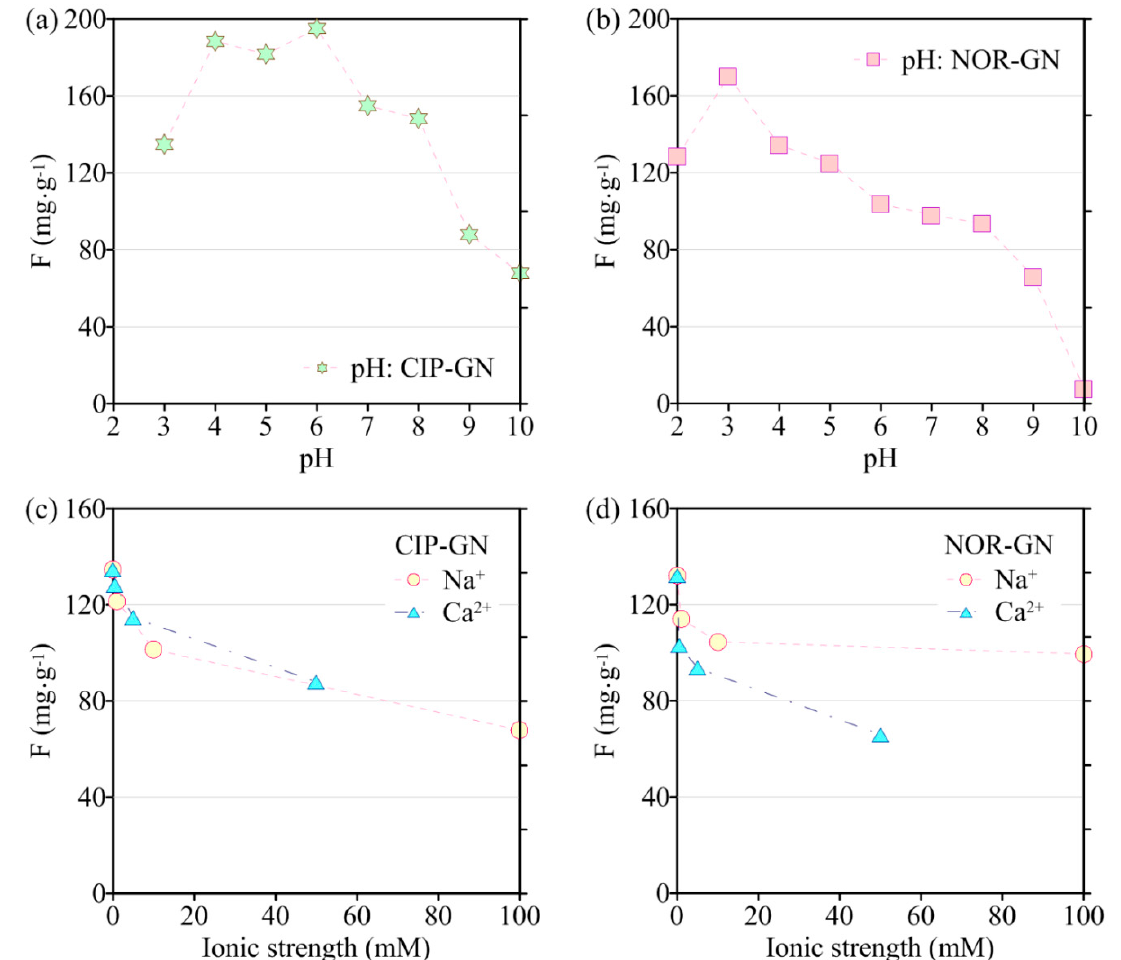
Figure 4. The effects of pH, ionic type and strength on the adsorption of QNs onto GN: ( a ) effect of pH on the adsorption of CIP onto GN; ( b ) effect of pH on the adsorption of NOR onto GN; ( c ) effects of ion types and ionic strength on the adsorption of CIP onto GN; ( d ) effects of ion types and ionic strength on the adsorption of NOR onto GN.